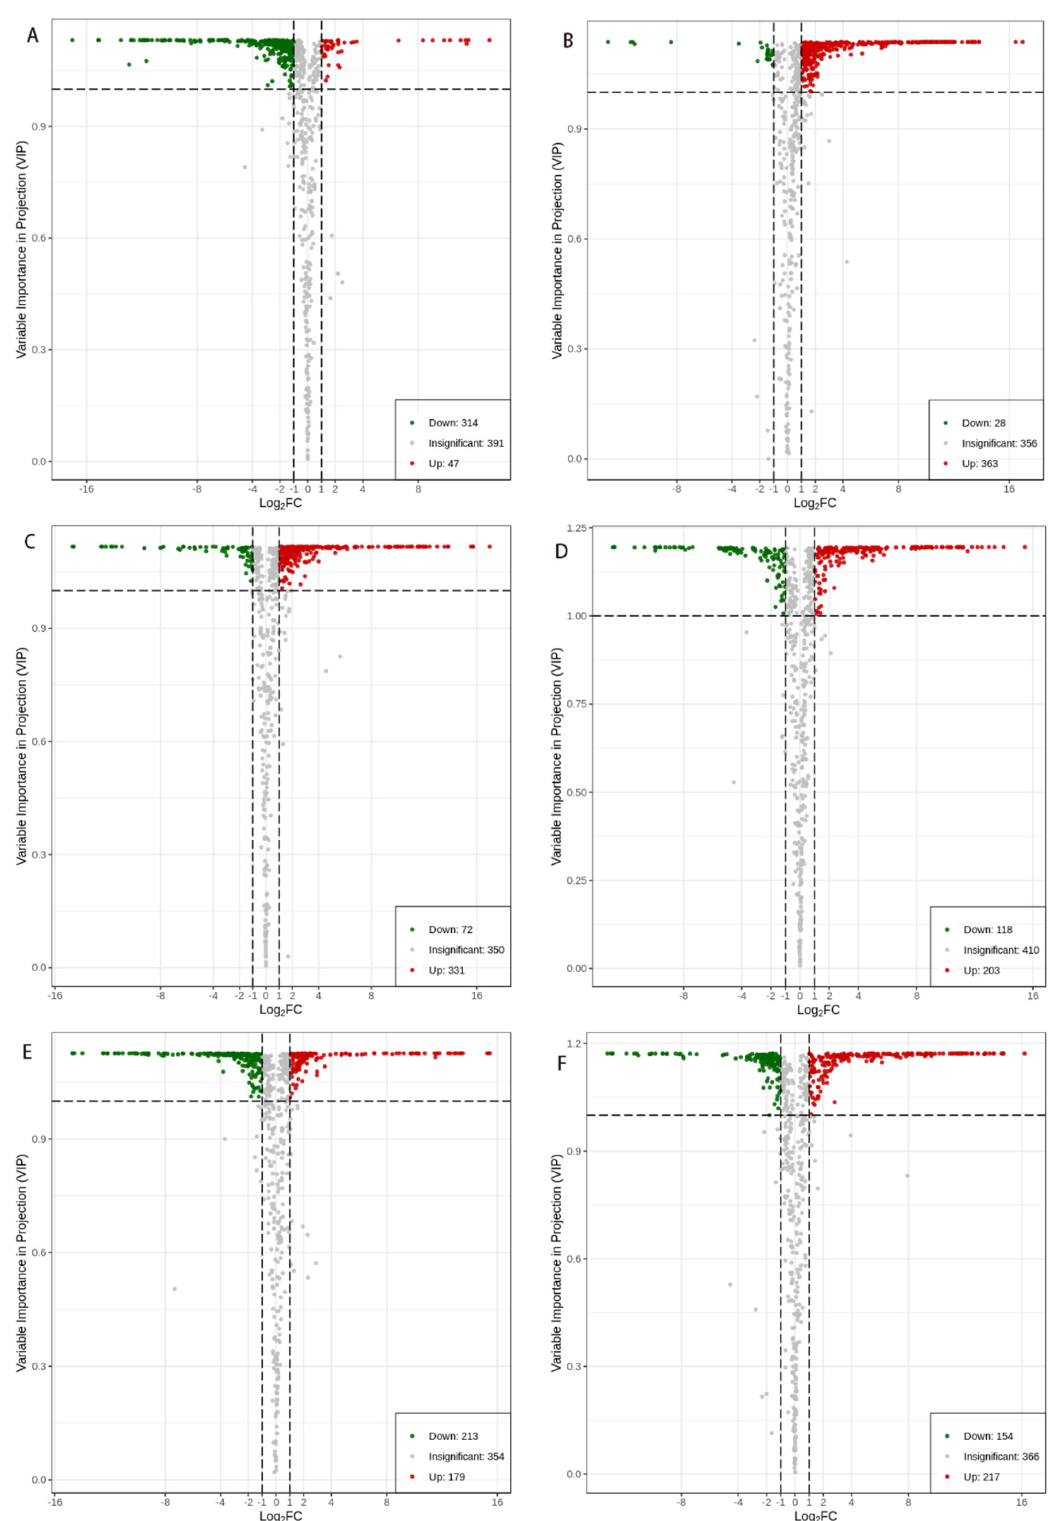
Figure 4. Volcano plots of differential metabolites presented in the two samples. ( A ) YS vs. CK; ( B ) YS vs. QS; ( C ) YS vs. JG; ( D ) CK vs. QS; ( E ) CK vs. JG; ( F ) JG vs. QS. The green points represent downregulated differentially expressed metabolites; the red points represent upregulated differentially expressed metabolites; and the black points represent metabolites that are detected but are not significantly different.